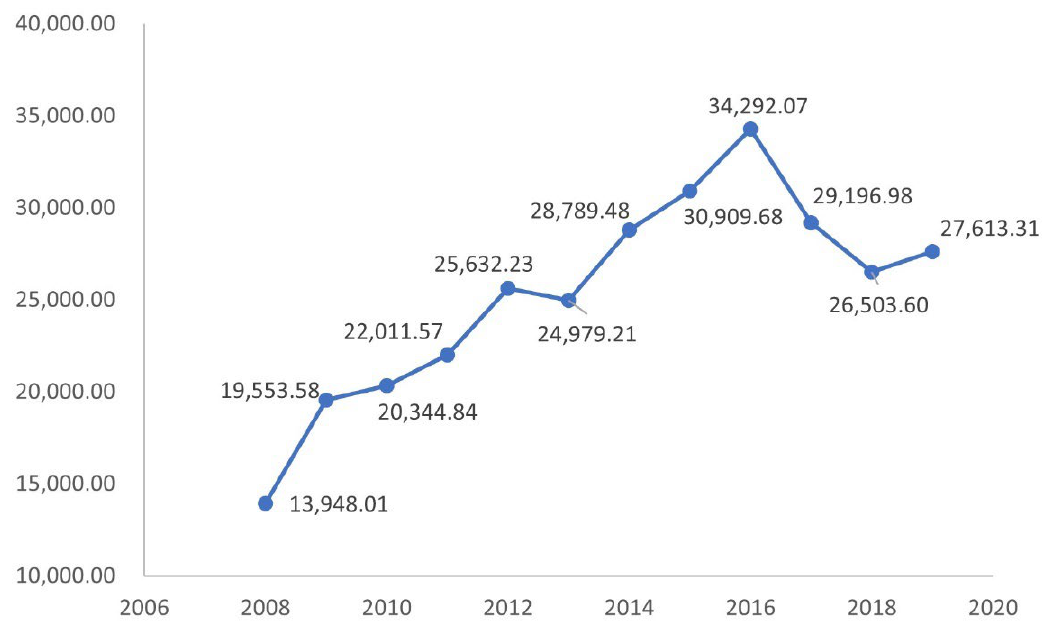
Unit: Yuan/m 3 . Data source: According to the statistical yearbook of Xinjiang.